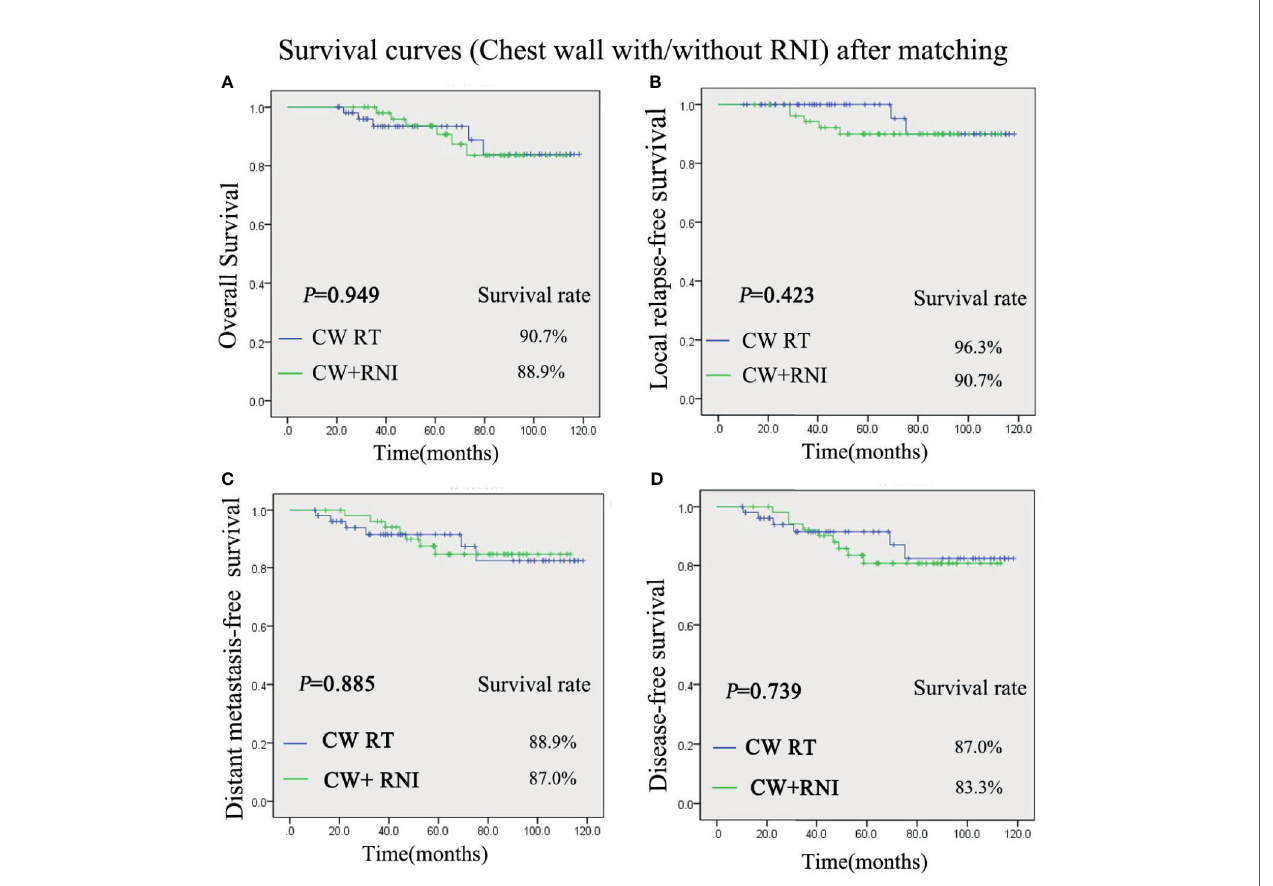
FIGURE 2 | Kaplan-Meier survival curves after propensity score matching (PMS) for group of chest wall radiation and group of chest wall + regional lymph nodes radiation. Overall survival (A) , disease-free survival (B) , local relapse-free survival (C) , and distant metastasis-free survival (D) . P values were calculated with the